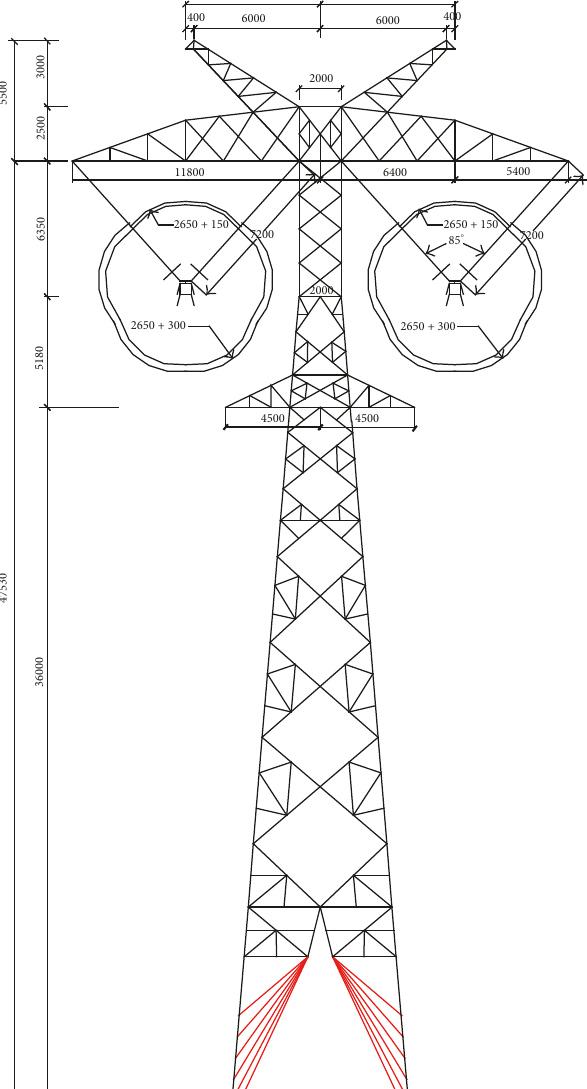
Figure 1: Schematic diagram of 4-terminal transmission lines.